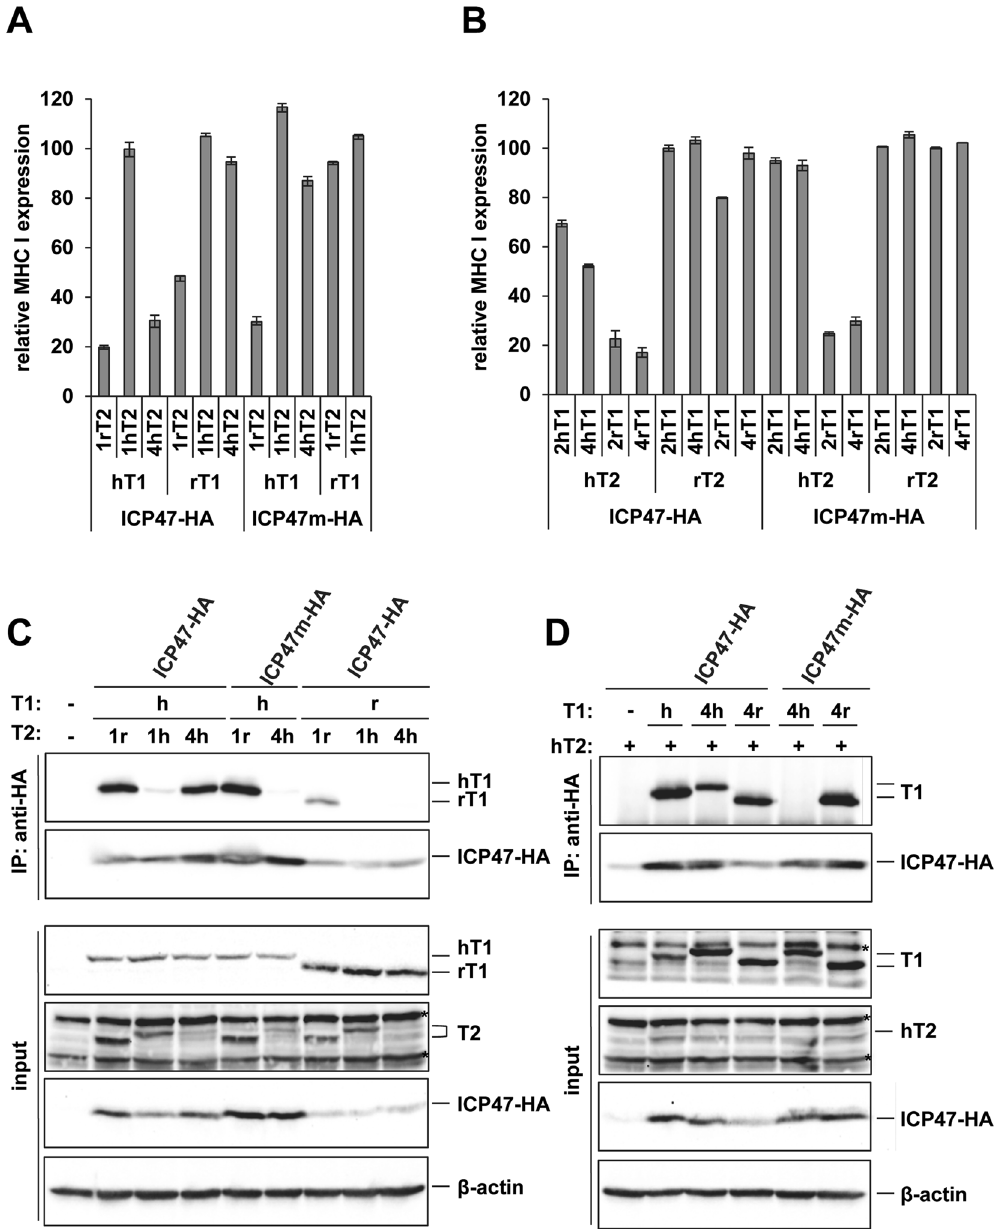
Figure 6. Divergent interaction sites of ICP47 on TAP1 and TAP2. Experiments were performed as in Fig. 4 with the indicated TAP chimeras (the FACS experiments shown in Figs 4 and 6 were performed in parallel). The figures ( A , C ) depict TAP2 chimeras (antibodies used for detection in B: TAP1, 148.3; ICP47-HA, anti-HA; TAP2 chimeras, anti-FLAG) and ( B , D ) TAP1 chimeras (antibodies used for detection in D: TAP1, anti-Myc; ICP47-HA, anti-HA; hTAP2, anti-FLAG). Original blots are shown in Fig. S10. Replicates of the co-IPs are shown in the Fig.